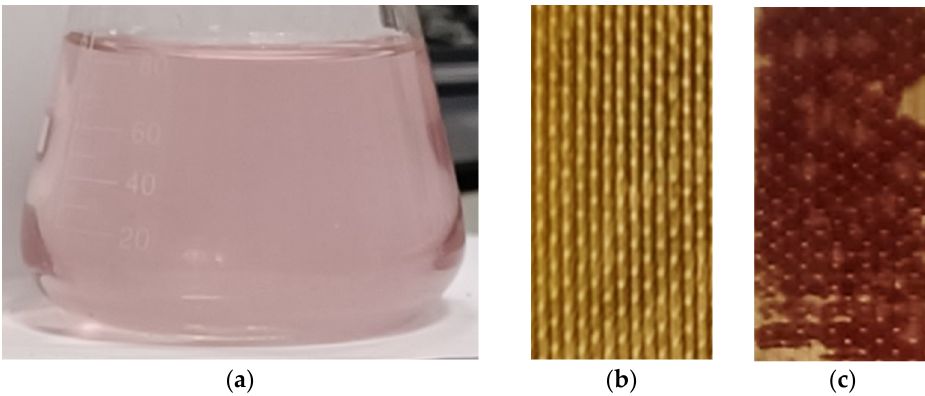
Figure 13. Photo of the cleaning solution ( a ) as well as the surfaces of the CJMA-6 anion-exchange membrane after cleaning in operando with ( b ) and without an electric field ( c ).